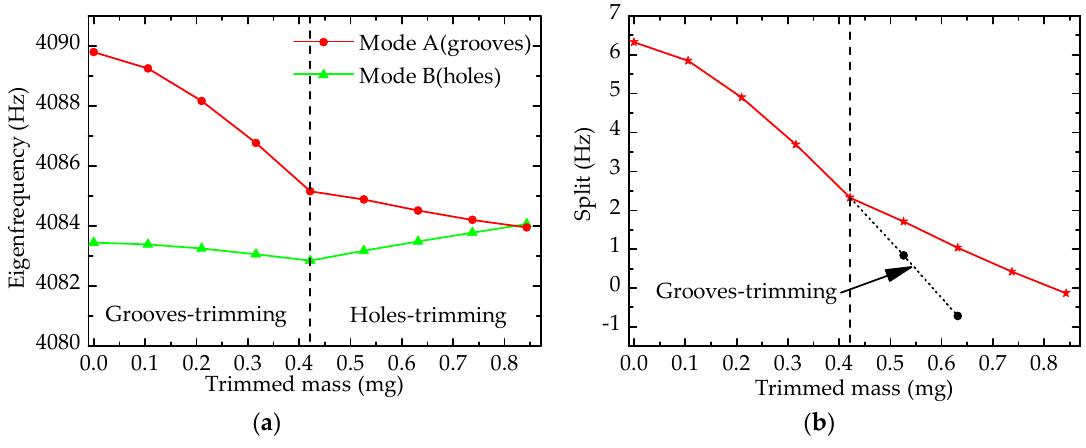
Figure 10. Simulation results of trimming process: ( a ) Eigenfrequency; ( b ) Frequency split.